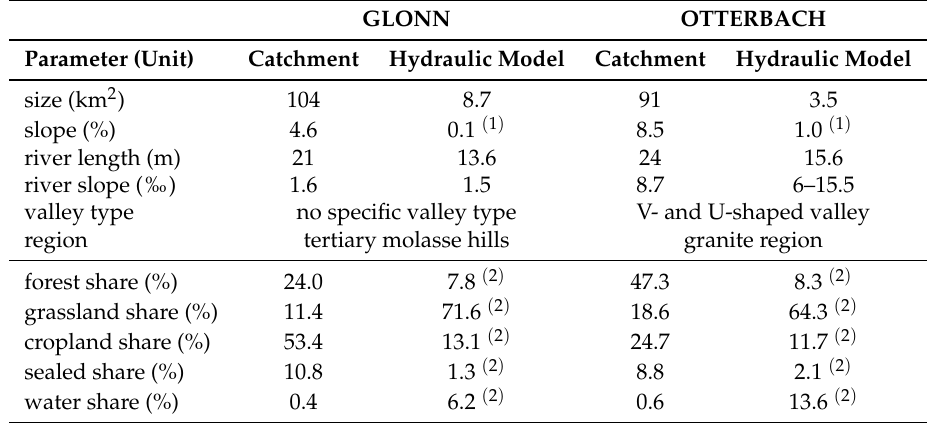
Table 1. Characteristics of the Glonn and the Otterbach catchment areas and the respective hydraulic